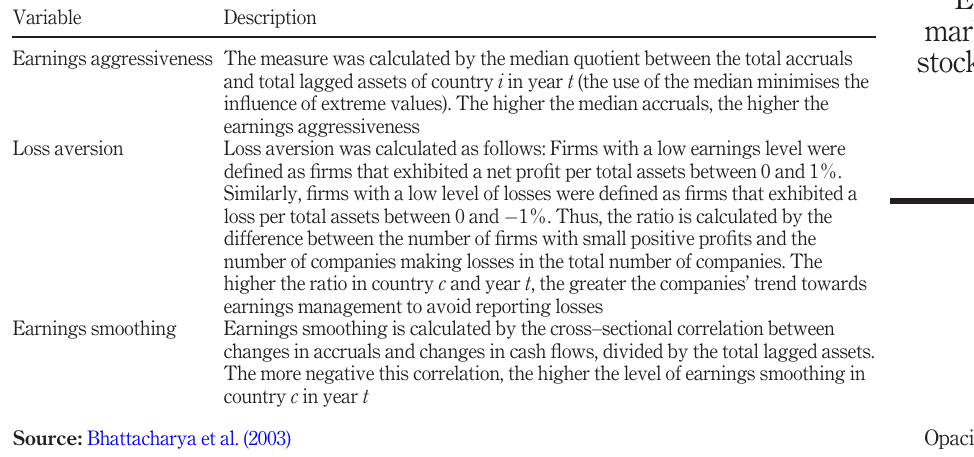
Table III. Opacity